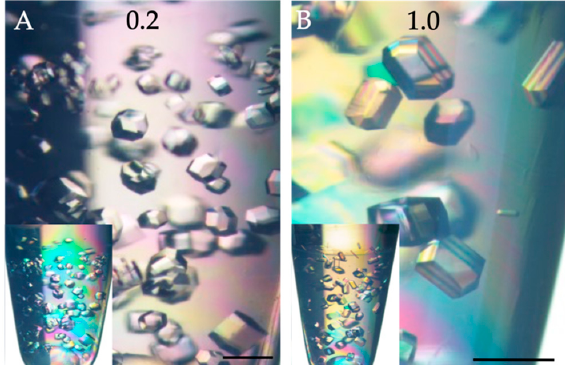
Figure 2. Lysozyme crystal grown in 0.2% w / v ( A ) and 1.0% w / v ( B ) Fmoc ‐ Y hydrogels by the 2 ‐ L counter ‐ diffusion technique. Inserts in the lower ‐ left part of A and B show the whole experiment. Scale bars correspond to 1.0 mm. Table 4. Summarized data collection conditions and final statistical values of lysozyme crystals obtained in Fmoc ‐ Tyr ‐ OH (Fmoc ‐ Y) and in agarose hydrogels (data in brackets correspond to high ‐ resolution shell).